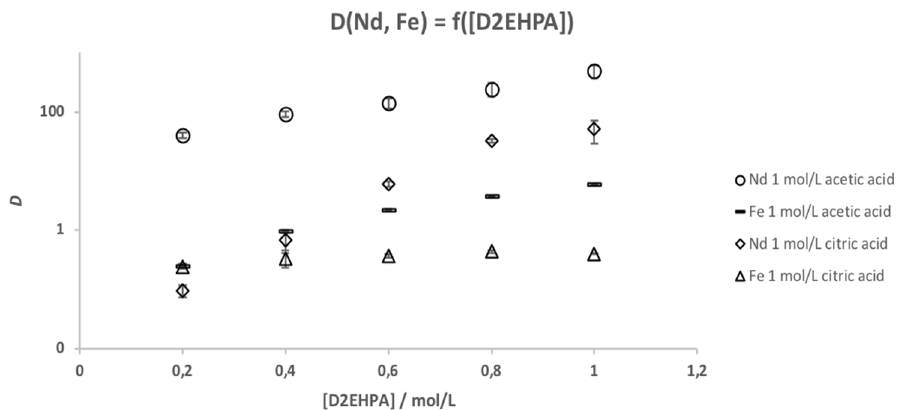
Figure 6. Distribution ratio of Nd and Fe as a function of the concentration of D2EHPA in a small-scale solvent extraction set-up ( V org / V aq = 1; 1 h shaking at 1500 rpm on an adaptable vortex mixer). The aqueous phase was a leachate (citric acid and acetic acid 1 M; S:L 1g /50 mL; 25 ◦ C; 24 h; 400 rpm stirring) using D2EHPA in Solvent 70 solutions as extracting agents, while temperature was thermostatically kept at 25 ± 1 ◦ C. Table 2. Separation factors between Nd and Fe after extraction with 0.2, 0.4, 0.6, 0.8, and 1 mol/L D2EHPA in Solvent 70. The aqueous phases used were 1 mol/L citric acid and acetic acid leachates previously obtained. Phase ratios were kept at V org / V aq = 1 during 30 min shaking at 1500 rpm on the custom-made shaking machine. Temperature was thermostatically kept at 25 ± 1 ◦ C. c (D2EHPA)/mol/L